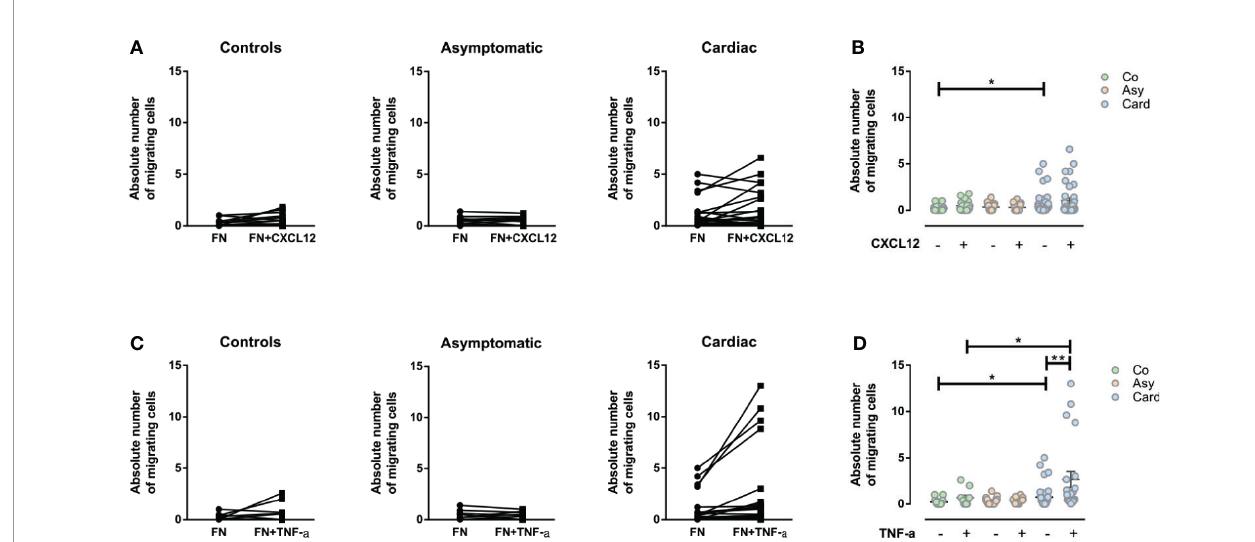
FIGURE 4 | Evaluation of the migratory capacity of peripheral blood mononuclear cells (PBMCs) driven by CXCL12 or TNF- a . (A) Graphs show the absolute numbers of by migrating PBMCs from control, asymptomatic, and cardiac subjects in transwell chambers coated by fi bronectin (FN) or FN+CXCL12. (B) The absolute number of migrating PBMCs in the different groups without and with CXCL12. (C) The absolute number of migrating PBMCs in transwell chambers coated with FN and FN+TNF- a from control, asymptomatic, and cardiac subjects. (D) The absolute number of migrating PBMCs in the different groups without and with TNF- a . In all cases, the values shown correspond to speci fi c migration after subtracting numbers obtained for each sample in wells coated with BSA alone. *p < 0.05 and **p < 0.01 versus Controls. Kruskal-Wallis followed by Mann-Whitney U test were used for statistical analyses. Co, Control (n = 20); Asy, Asymptomatic (n = 20); Card, Cardiac (n =